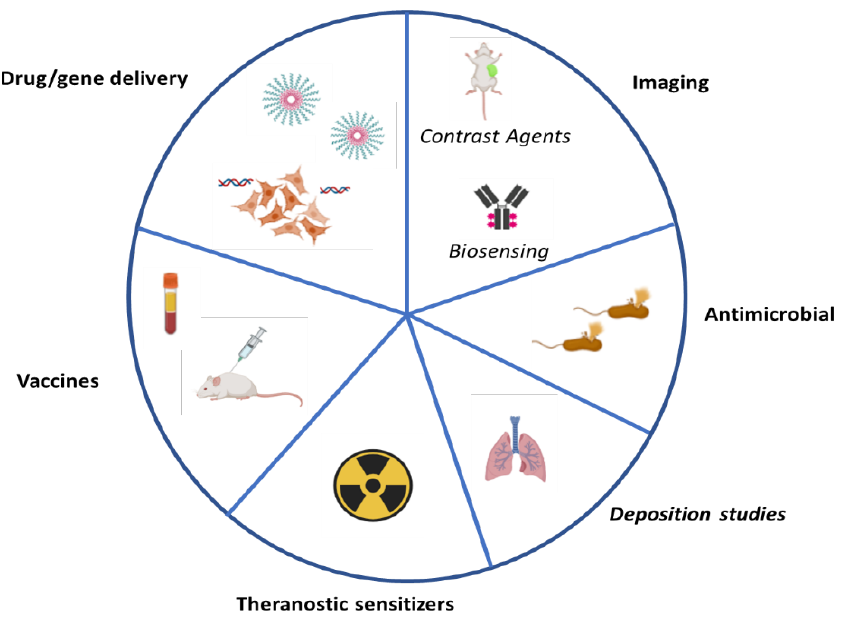
Figure 10. Main biological applications of gadolinium-based oxides. Created with https://biorender.com/ (accessed on 7 September 2021).